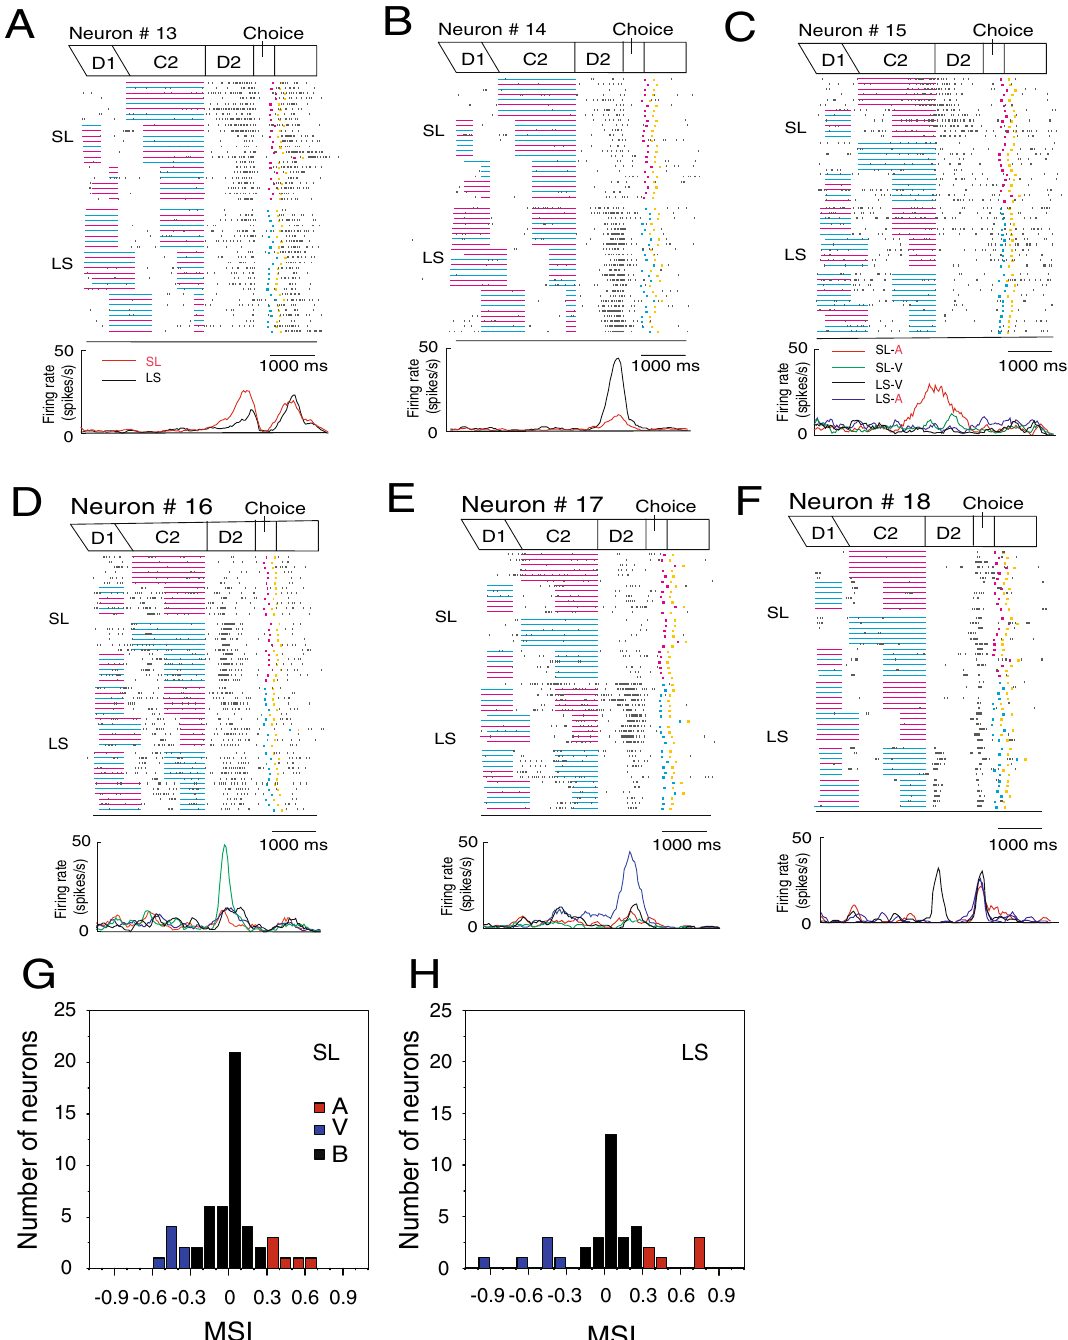
Figure 6. Activity of D2-responsive neurons. ( A ) A D2-responsive neuron showing greater D2 activity in the SL trials than in the LS trials. A raster diagram and firing rate curves are aligned with D2 onset. The raster display is separately shown in the SL and LS trials and is rearranged by the C2 duration from long to short. Firing rate curves show changes in activity for the SL (red) and LS (black) trials. ( B ) A D2-responsive neuron showing greater D2 activity in the LS trials than in the SL trials. ( C ) A D2-responsive neuron showing selective D2 activity in the SL trials with auditory C2. The raster display is separately shown in the SL and LS trials and for the C2 modality. Firing rate curves show changes in activity for the SL trials with auditory (red) and visual (green) C2, and in the LS trials with auditory (blue) and visual (black) C2. ( D ) A D2-responsive neuron showing selective D2 activity in the SL trials with visual C2. ( E ) A D2-responsive neuron showing selective D2 activity in the LS trials with auditory C2. ( F ) A D2-responsive neuron showing selective D2 activity in the LS trials with visual C2. ( G ) Distribution of the MSI to the LS type of D2-responsive neurons. MSI = (VIS − AUD)/ (AUD + VIS). AUD is D2 activity after auditory C2, and VIS is the D2 activity following visual C2. ( H ) Distribution of the MSI to the SL type of D2-responsive